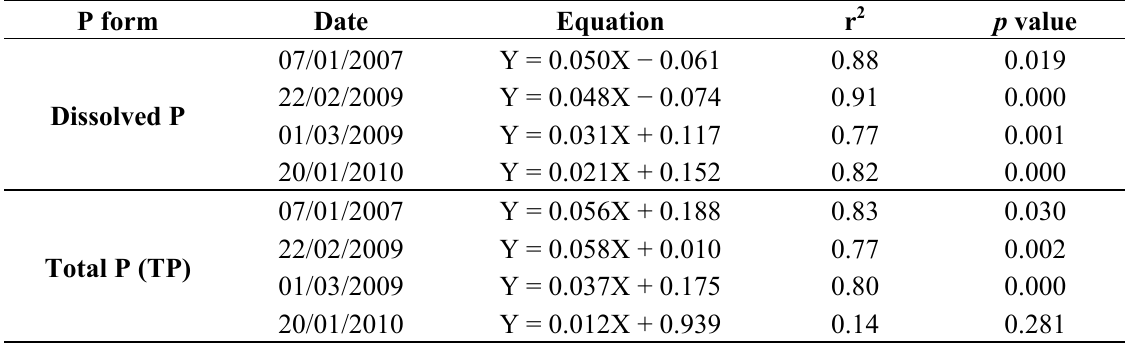
Table 4. Regression analysis results between P concentrations in the streams and P-index values computed by the Hermon